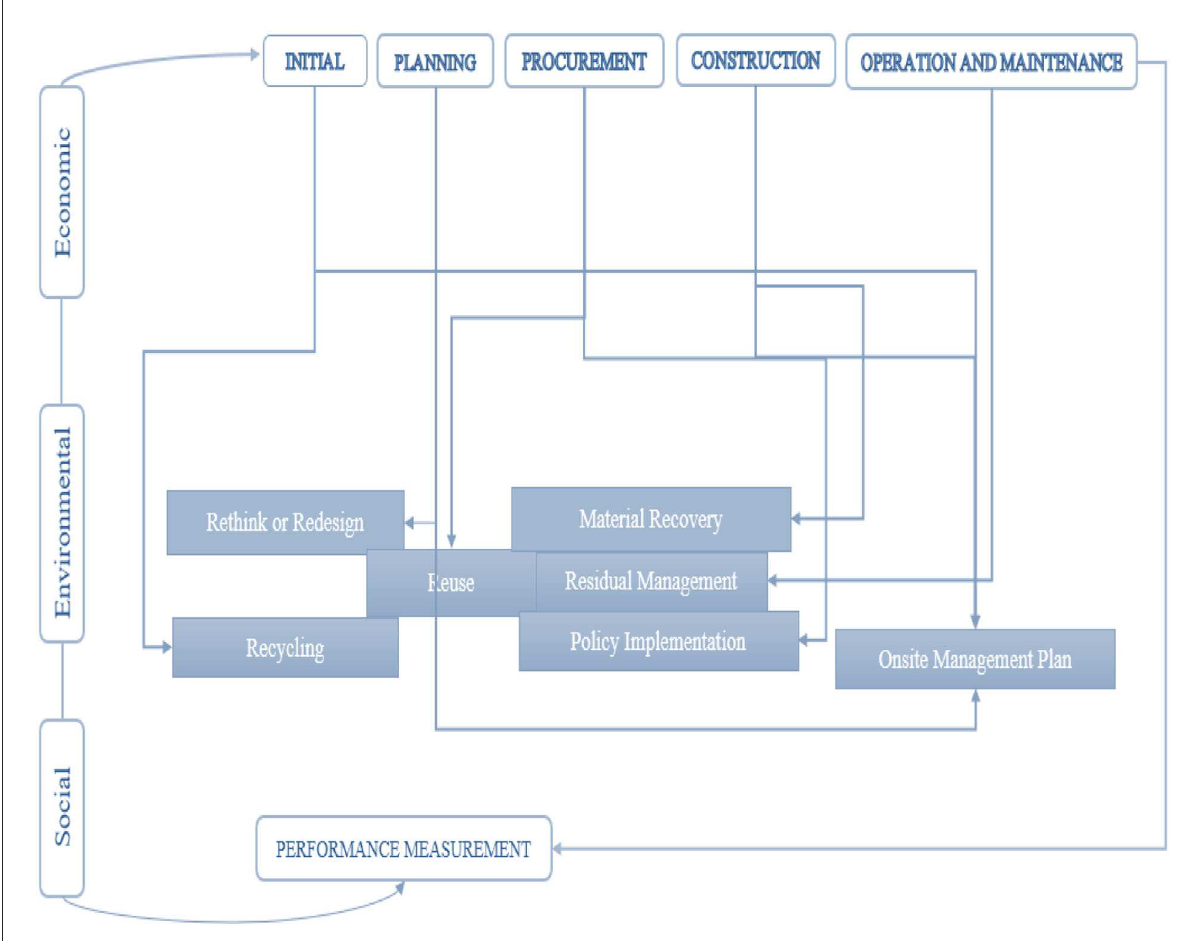
FIGURE4 Flowchart of LCA material flow